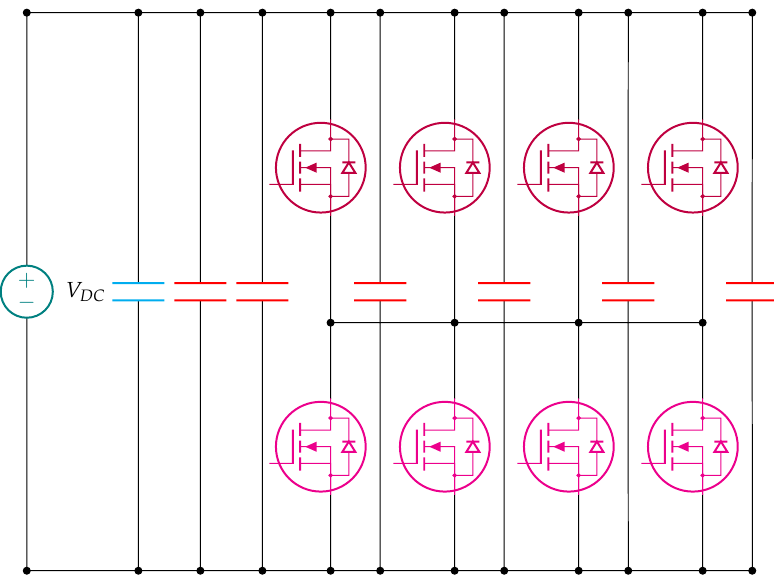
Figure 10. Location of 6 µ F Ceralink capacitance connected in parallel through discrete MOSFETs.